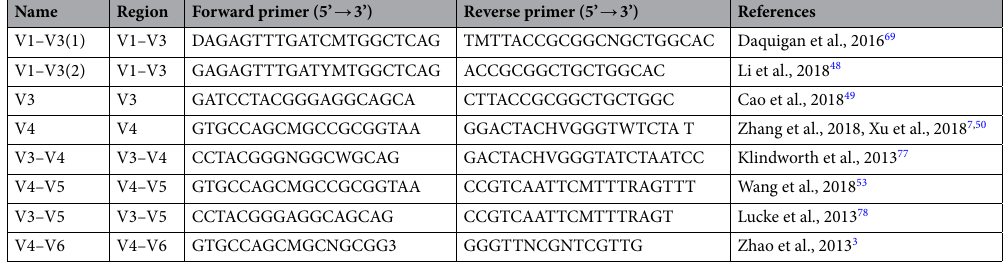
Table 1. 16S rRNA primers used to analyze microbiota diversity, composition and function in chicken cecal